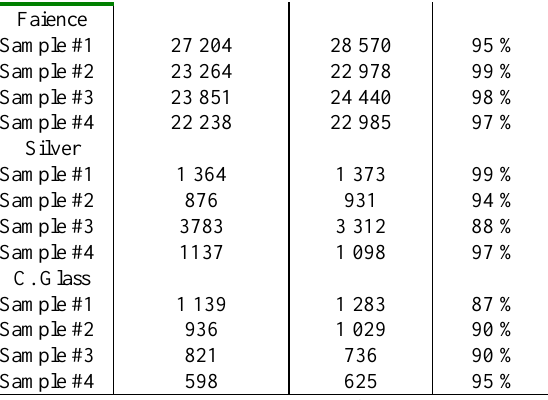
Tableau 2 Segmentation accuracy of tesserae samples The tesserae recognition pipeline including segmentation, classification and information extraction was conducted over 3 different representative zones of the point cloud in order to be exhaustive and have the ability to count manually each tesserae for assessing the results. In the first zone containing 12 184 307 points, three types of tesserae were studied: 138 Gold tesserae from the XIX century renovation (NG), 239 ancient gold (AG) and 11 faience tesserae (FT) (Figure 13). The automatic segmentation correctly recognized all FT (100% accuracy) and 331 golden tesserae (GT) (88% accuracy), remaining ones being 5% of under-segmentation (in groups of 2/3 tesserae), 7% of tesserae not detected. The classification correctly labelled respectively 100% FT, 98% NG, and 99% AG.